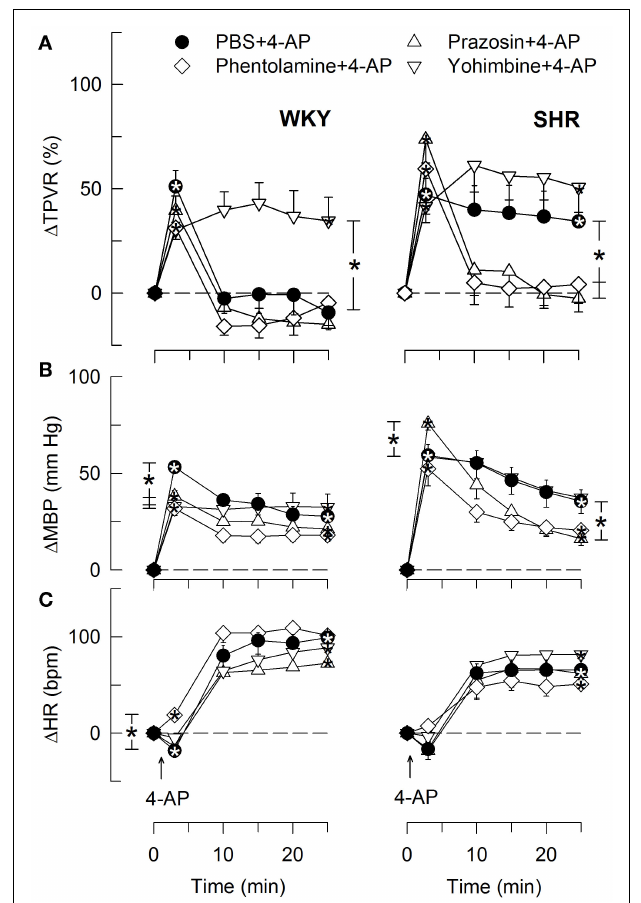
FIGURE 9 |TheTPVR- (A), MBP- (B), and HR- (C) response to 4-AP in WKY and SHR after pre-treatment with α AR antagonists. Significant responses (* within symbol) and group differences during the immediate TPVR max and at 25min (brackets) were located as indicated. All antagonists reduced baselineTPVR inWKY, but not significantly in SHR ( Table 2 ). Baseline MBP was lower after all three antagonists inWKY and after phentolamine and prazosin in SHR. Baseline HR was lower after phentolamine inWKY and after phentolamine and prazosin in SHR ( Table 2 ). * – P ≤